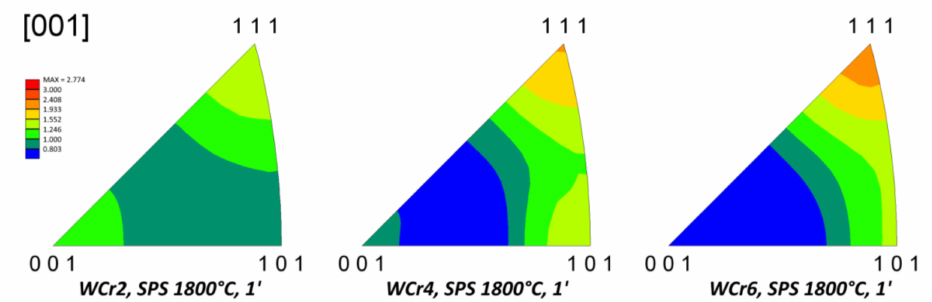
Figure 10. Inverse pole figures calculated from the three EBSD mappings (Figure